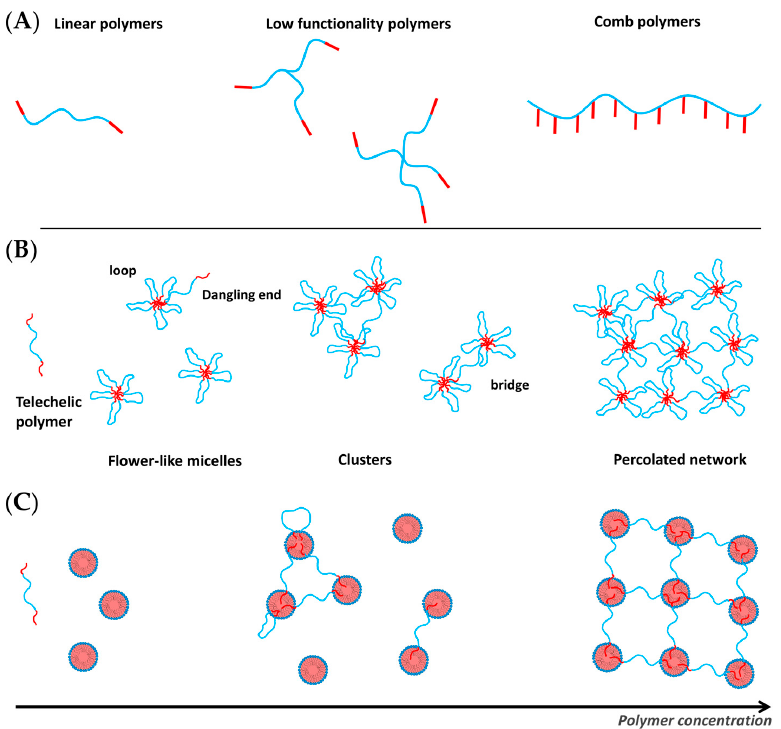
Figure 7. Schematic representation of ( A ) the polymer architecture of linear and low functionality telechelic polymers and comb-type hydrophobically modified polymers; association of telechelic polymers in ( B ) aqueous solutions and ( C ) with microemulsions as a function of the polymer